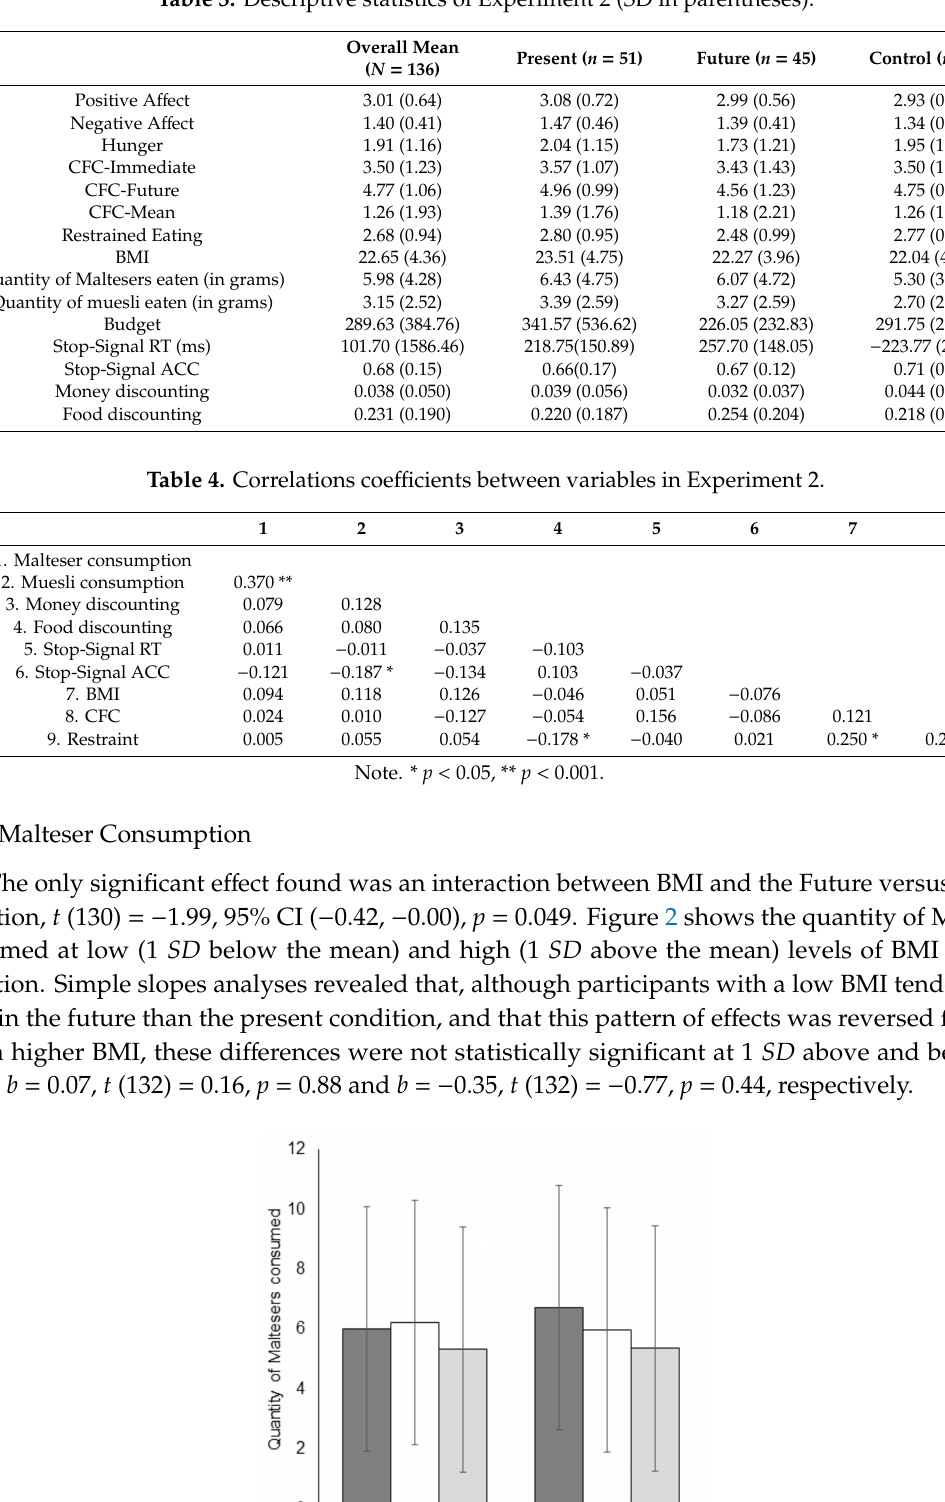
Table 3. Descriptive statistics of Experiment 2 (SD in parentheses).